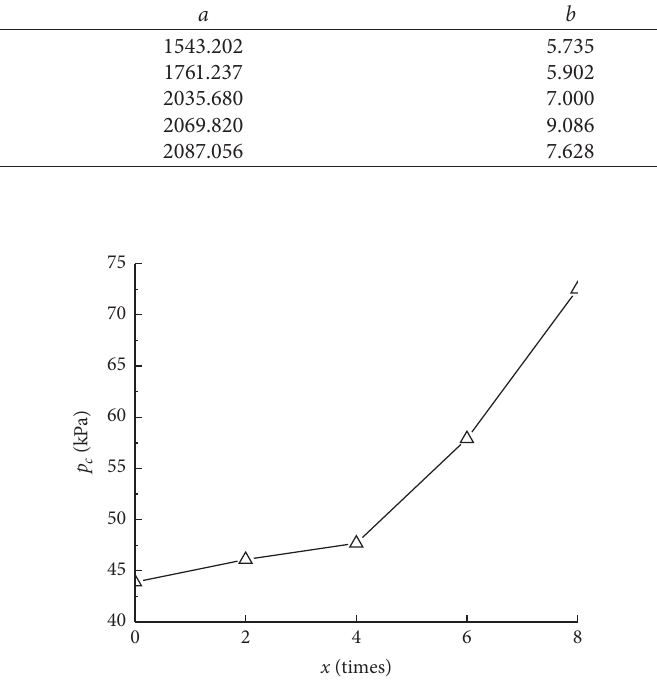
Figure 7: Relationship between pc and times of treatment, x .